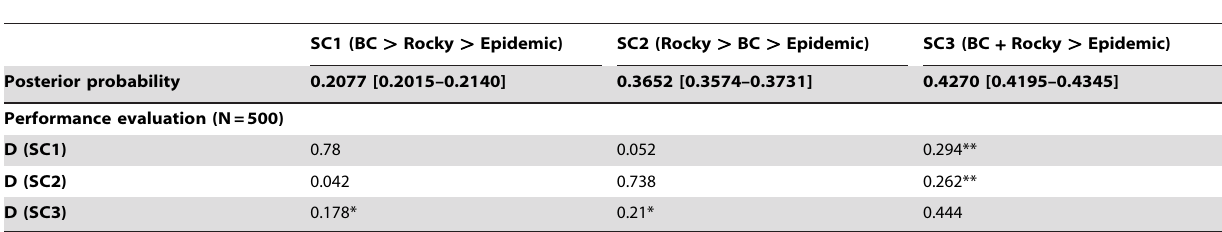
Table 6. Model choice and robustness on model choice for discrimination among three scenarios (SC).